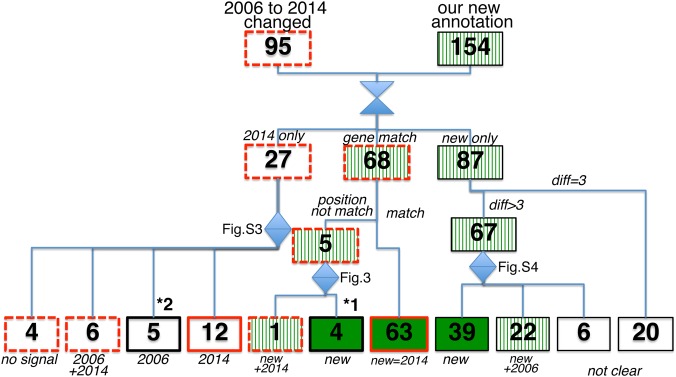
Confirmation flowchart of possible new initiation sites of known genes. Boxes with dark gray (red) lines indicate genes changed annotation in 2014 annotation record; dashed lines indicate unconfirmed or inconclusive changes. Shadowed boxes (green) indicate genes changed by our analysis; stripes indicate unconfirmed or inconclusive changes. Boxes denoted *1 and *2 are 2014 annotation changes that did not match with our analysis. See text for further explanation. This figure is available in black and white in print and in colour at DNA Research online.